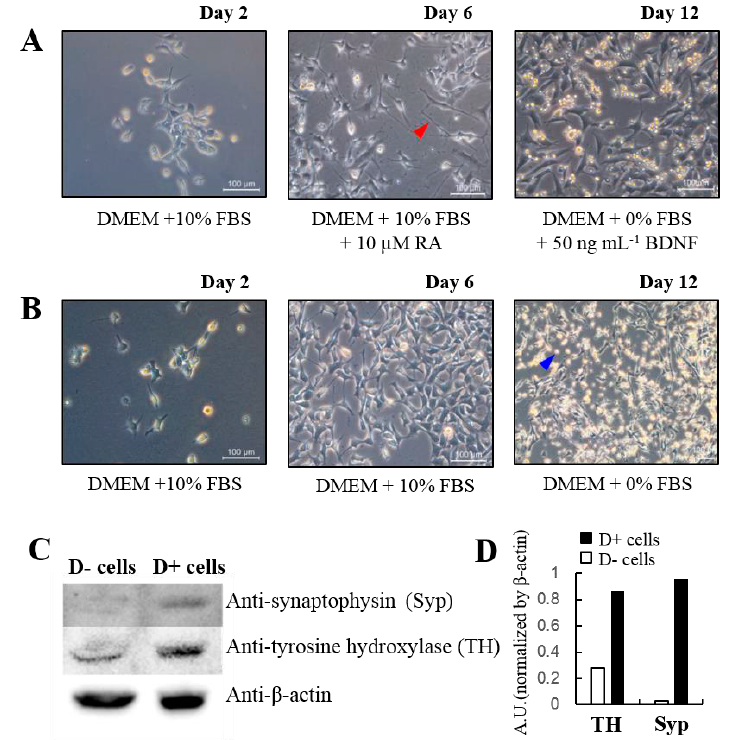
Figure 2 . Phase contrast images of cultured cells ( A ) with and ( B ) without cell differentiation factors, RA and BDNF. Western blot analysis ( C ) with differentiated, D+, and non-differentiated, D − , cells